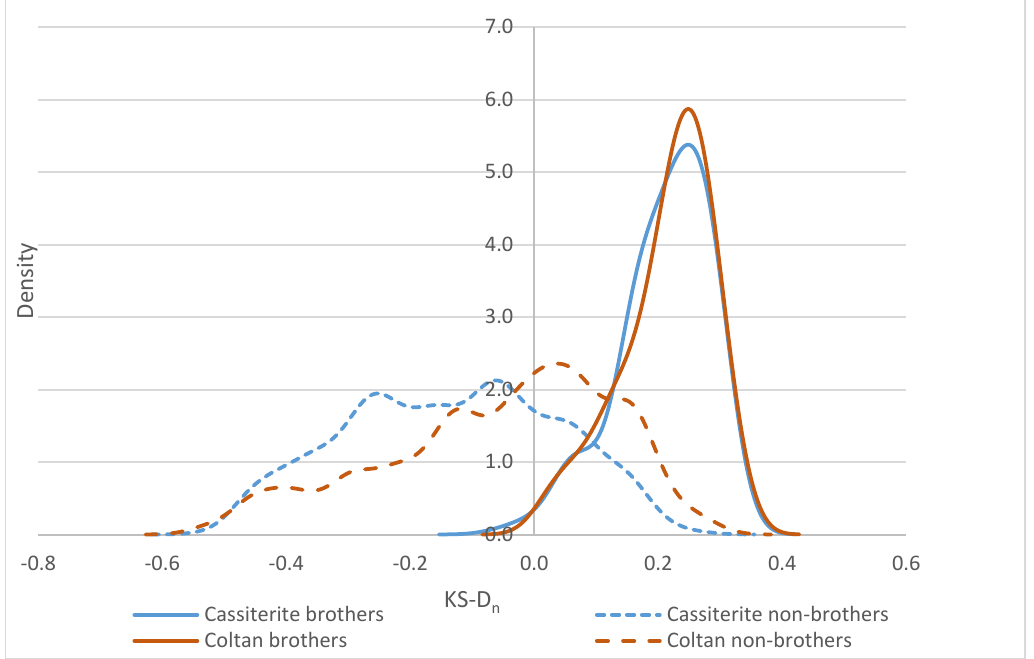
Figure 1. Distributions of brother and non-brother comparison test sets of KS-D n of cassiterite and coltan for the respective decision criterion (DC) calculated with 3σ.